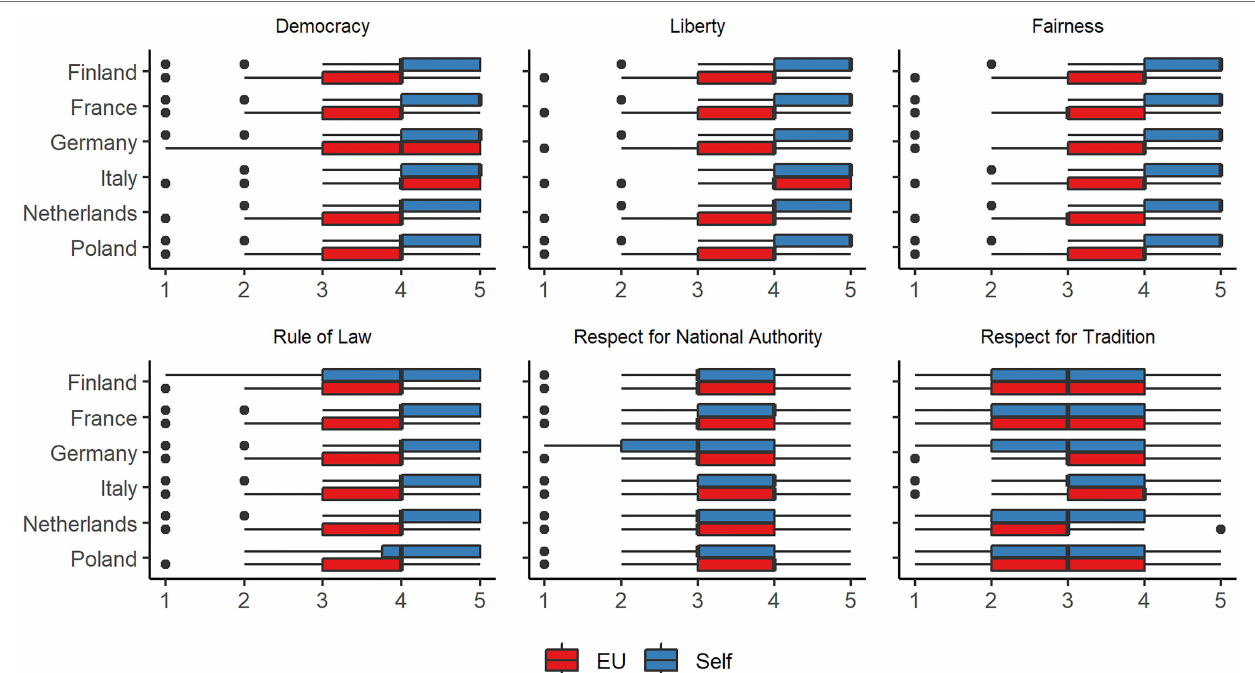
FIGURE 1 | The distribution of personal values and perceived values of the EU in all country